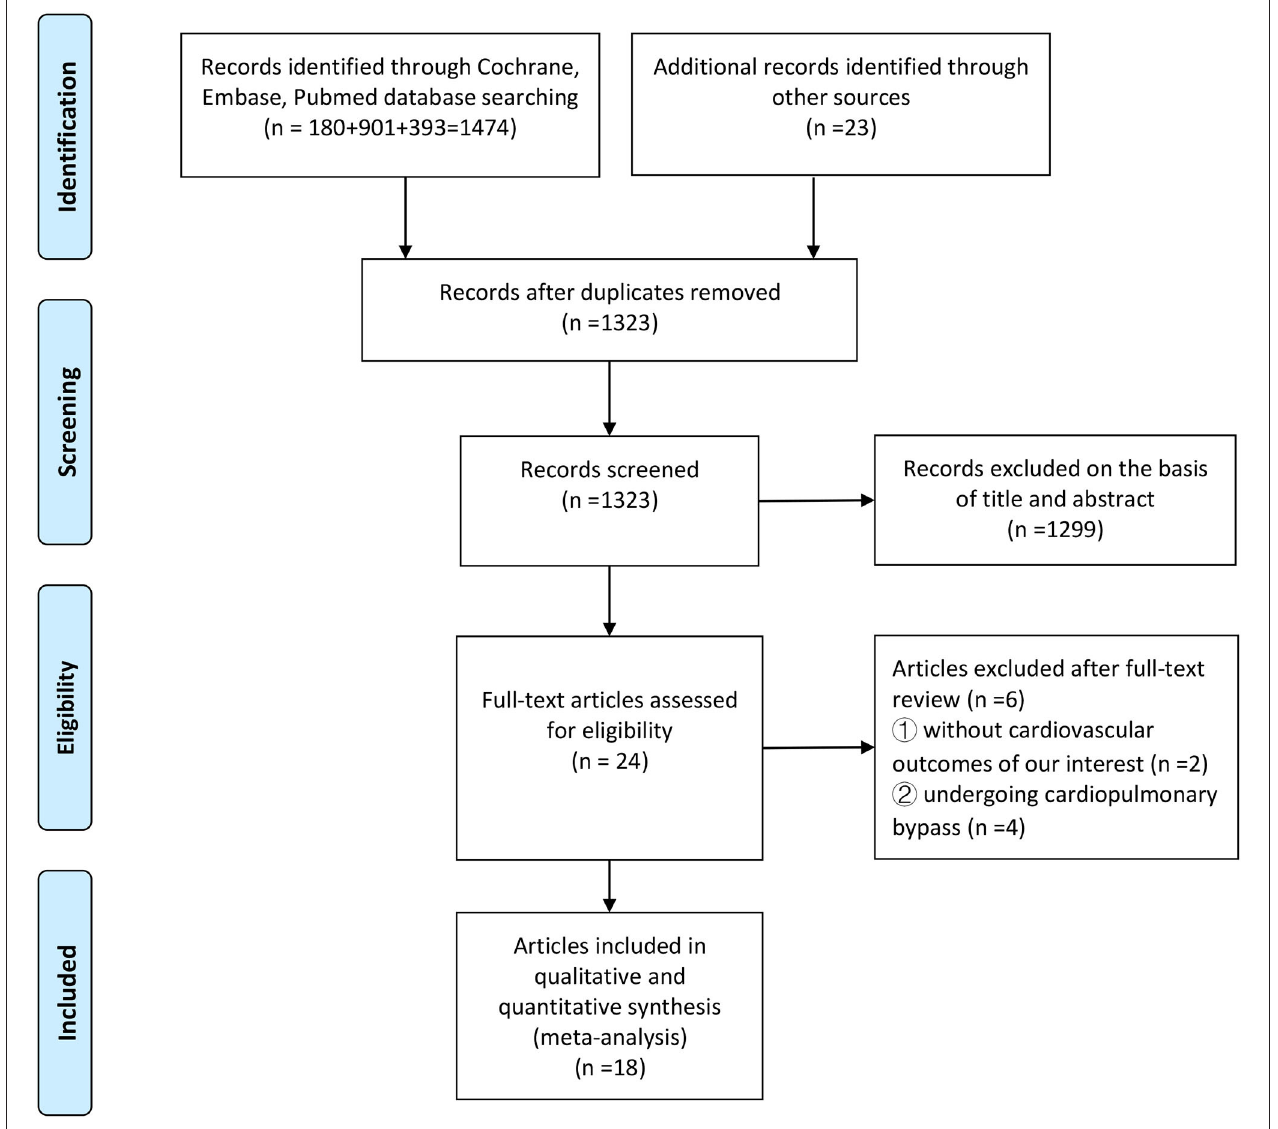
FIGURE 1 | Study selection